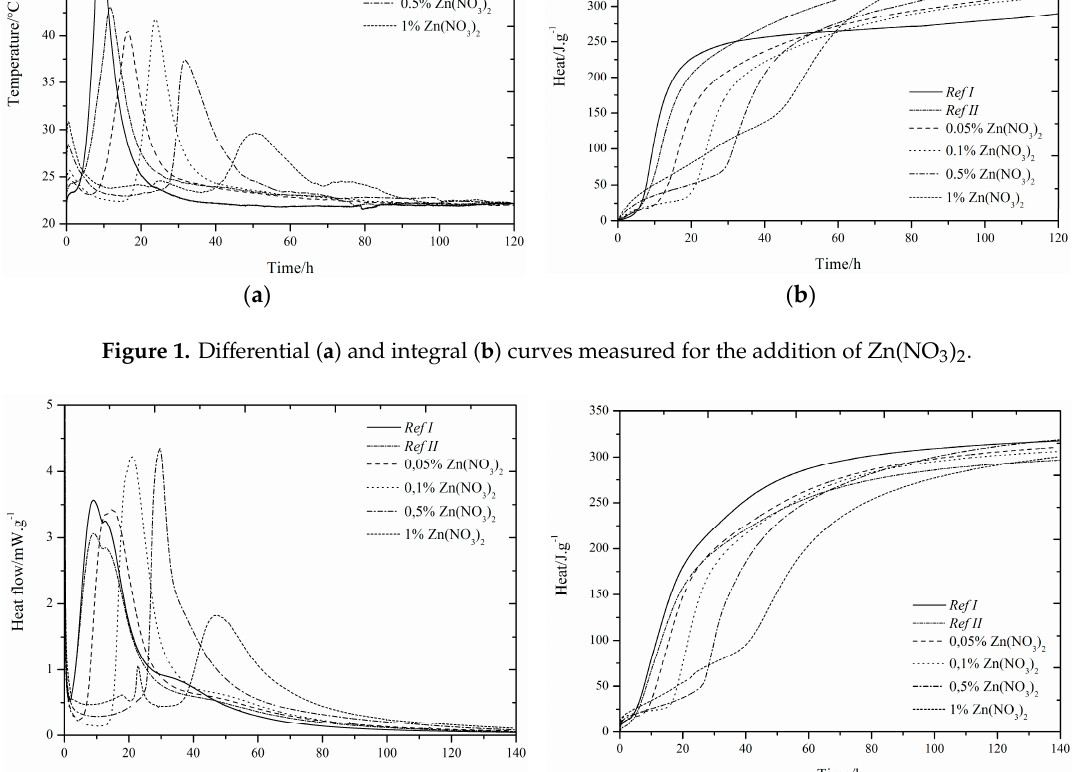
Figure 2. Differential ( a ) and integral ( b ) curves measured for the addition of Zn(NO 3 ) 2 . Figure 2. Di ff erential ( a ) and integral ( b ) curves measured for the addition of Zn(NO